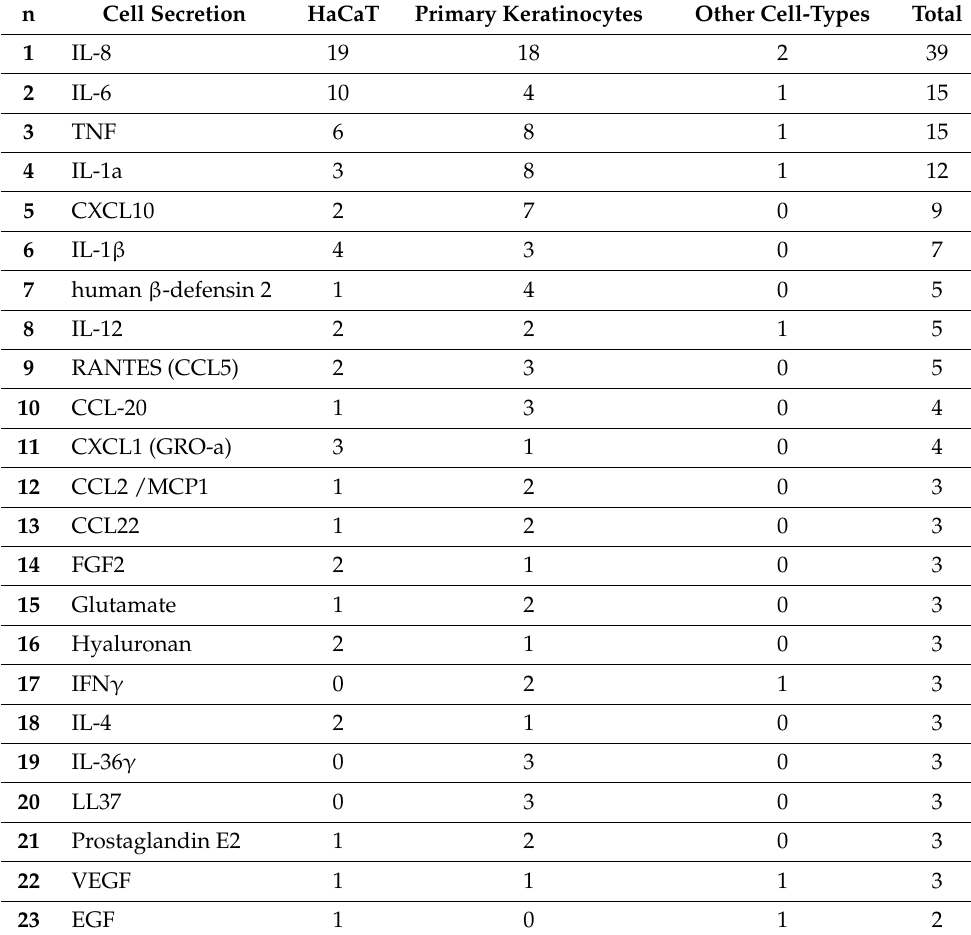
Table 2. The frequency of reported secretions in cell culture supernatant, according to the cell-type. n Cell Secretion HaCaT Primary Keratinocytes Other Cell-Types